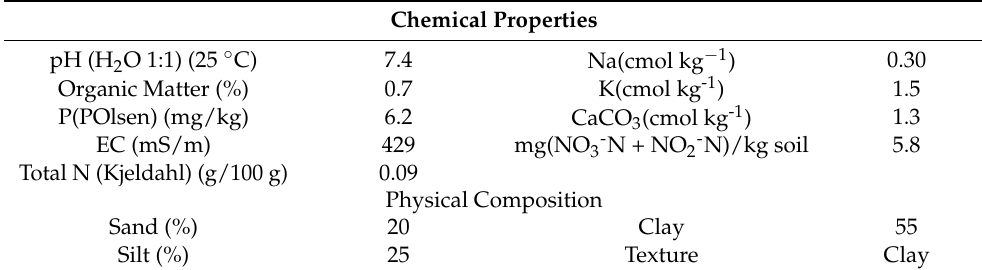
Table 1. Soil properties of the experimental site.